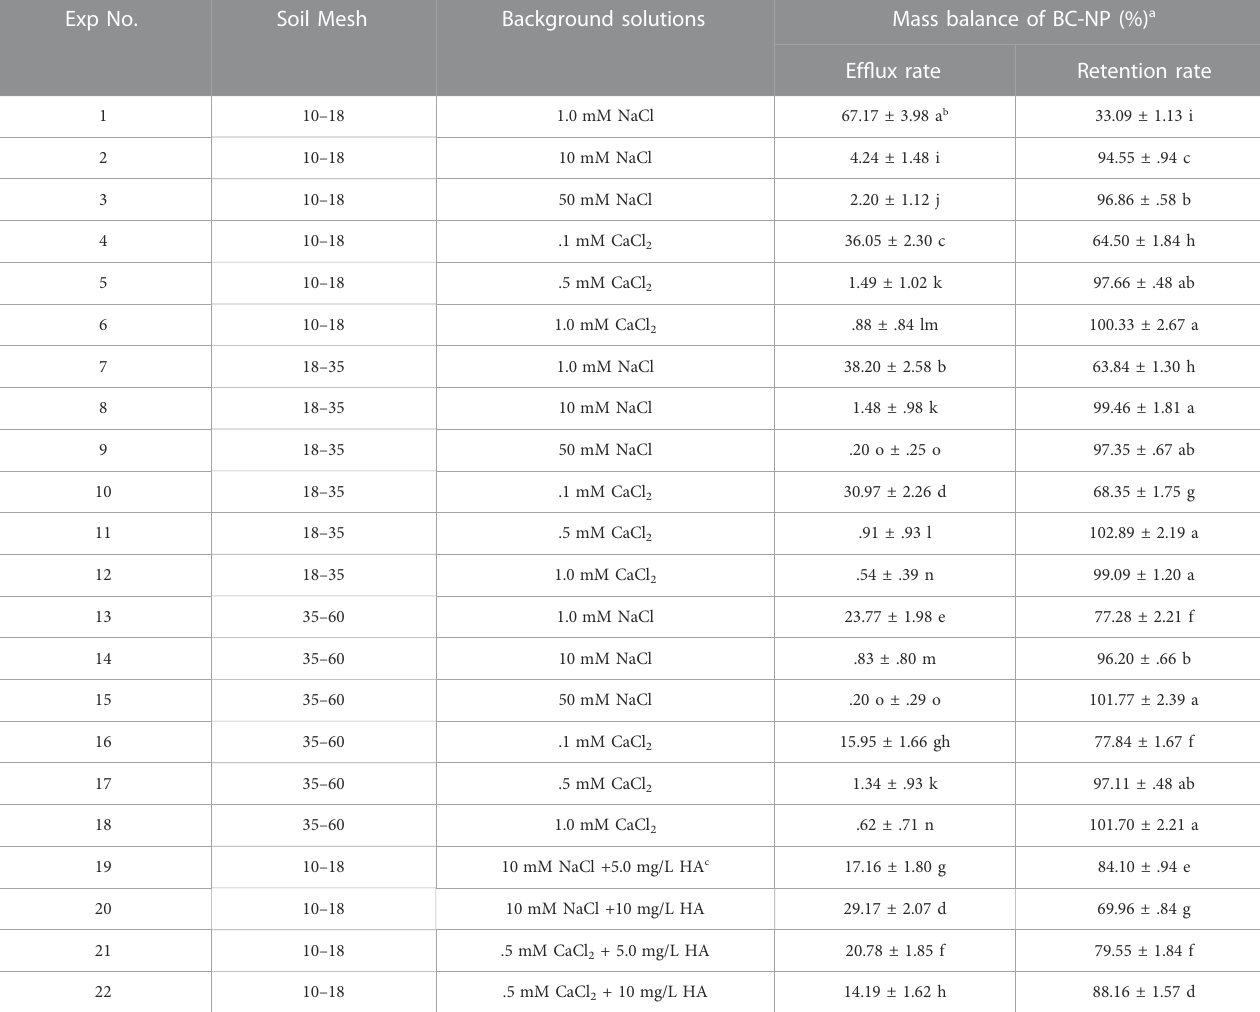
TABLE 1 Mass balance percentages of BC-NP at different experimental conditions. Exp